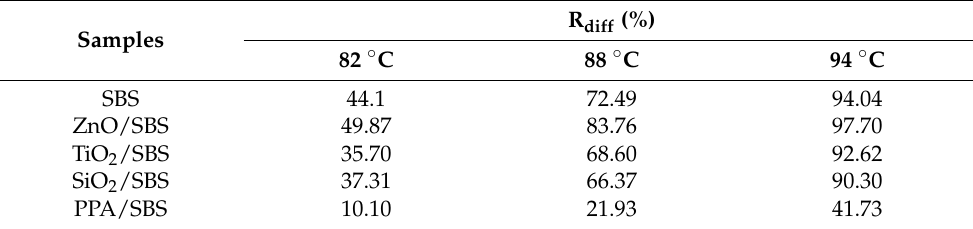
Table 2. Recovery rate difference R diff of various modified asphalts at different temperatures.